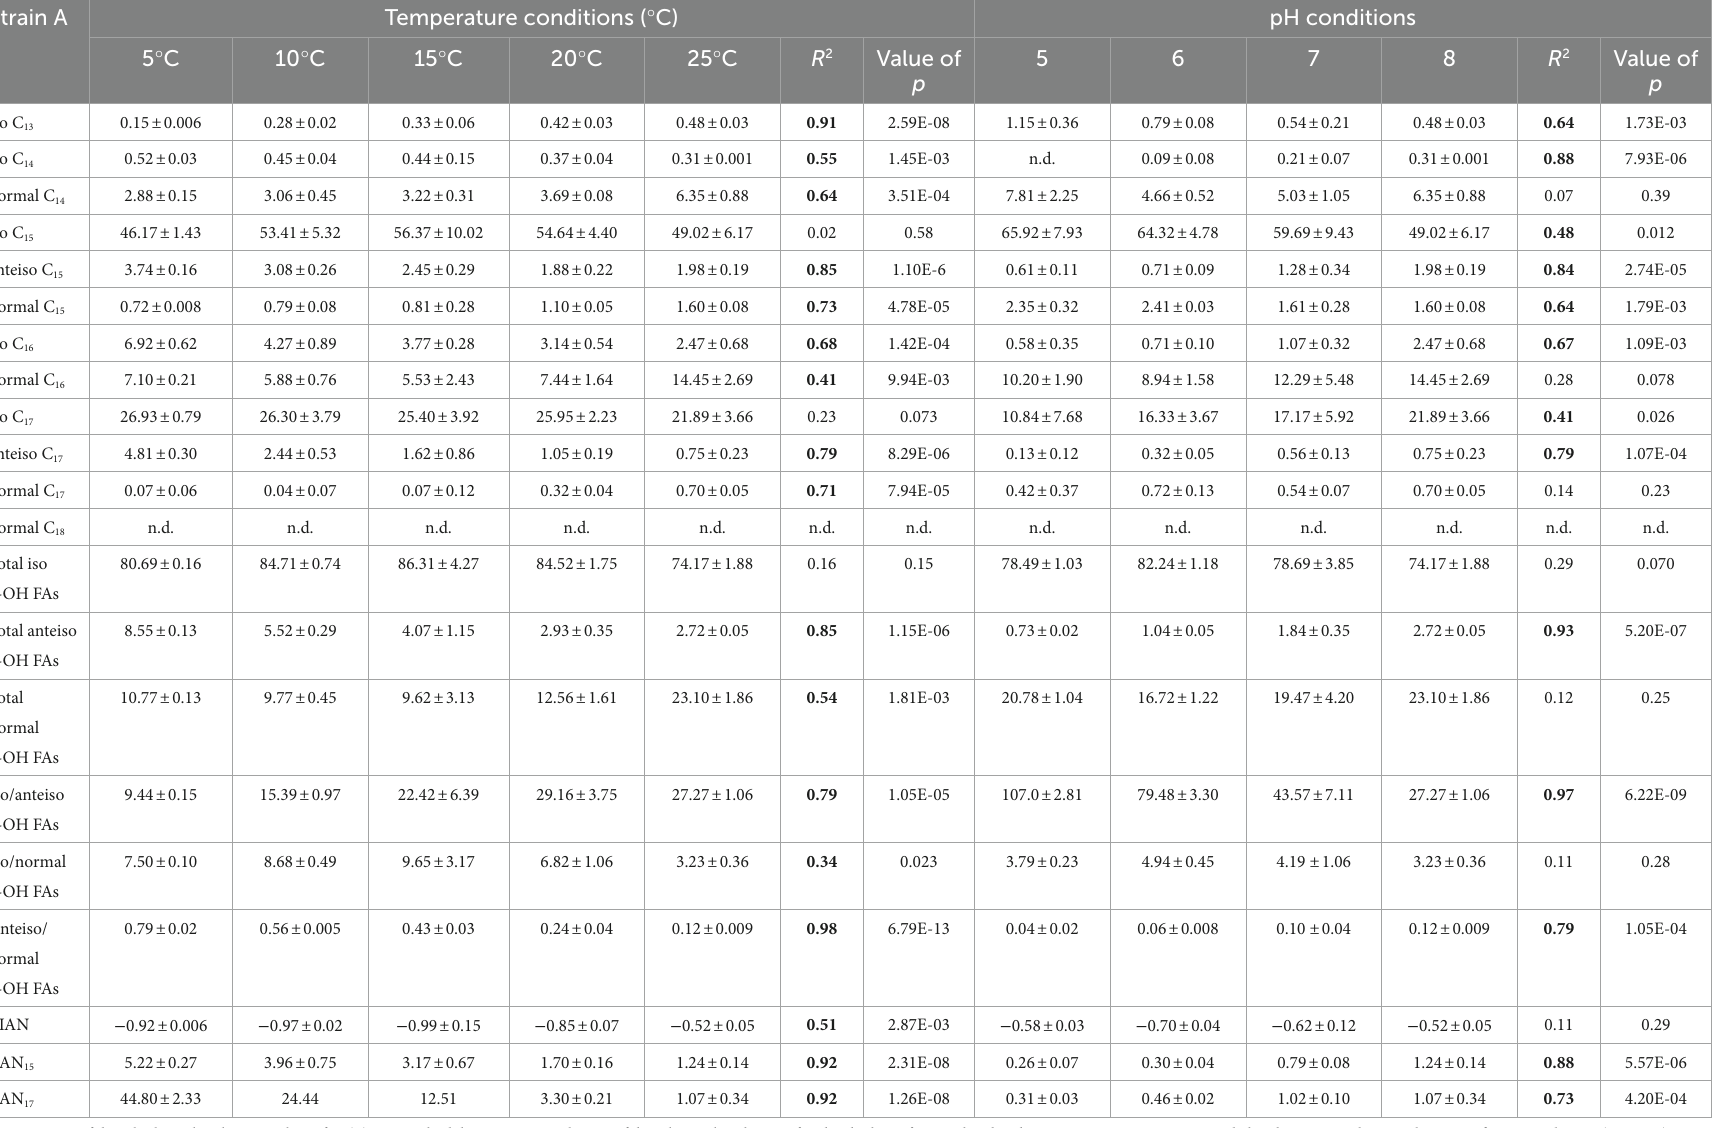
Data are means of three biological replicates. Values after (±) are standard deviations. Correlations of the relative abundances of each 3-hydroxy fatty acid with either temperature or pH are provided with corresponding p -values. Significant correlations ( p < 0.005) are indicated in bold. n.d.: not detected. Strain A: Flavobacterium pectinovorum (98.78%